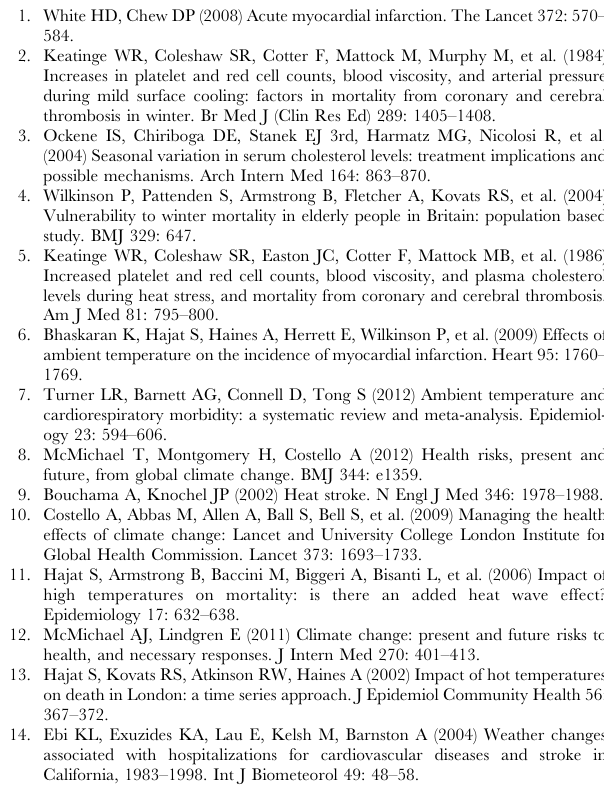
Central and Southern regions: Table S1. Summary Statistics of Central region for Temperature and other Meteorological Variables with the Level of Air pollutants by Season: Table